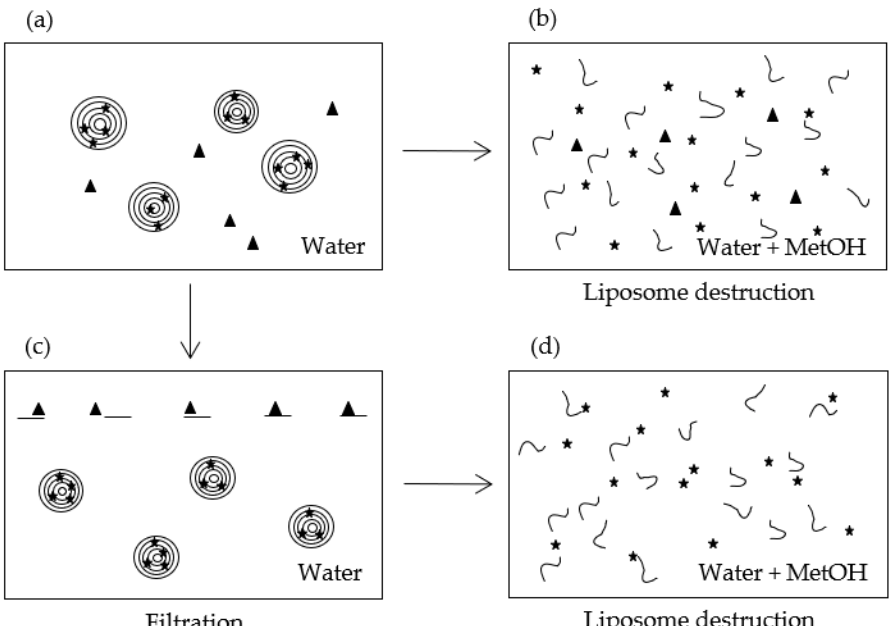
Figure 2. Scheme illustrating the different schemes of the method. ( a ) Dispersion of ε Vin-loadedMLLs in water, ( b ) destruction of ε Vin-loadedMLLs, ( c ) filtration of the ε Vin-loaded MLLs dispersion, ( d ) destruction of the filtrated the ε Vin-loaded MLLs dispersion. The stars correspond to encapsulated molecules, the triangles to free molecules.